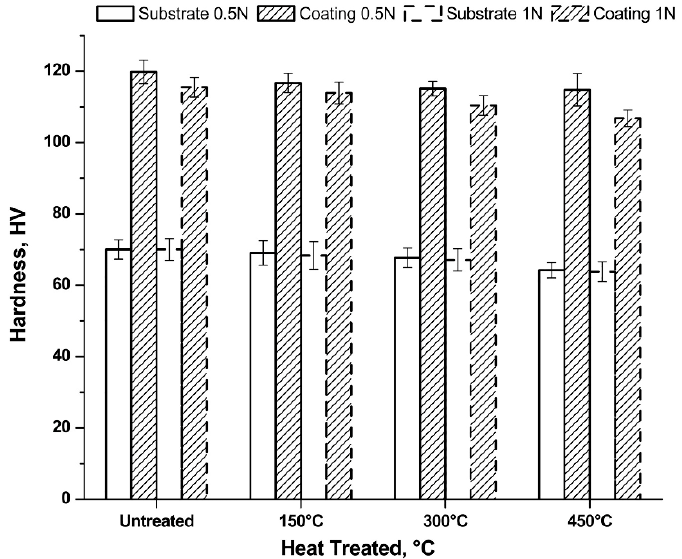
Figure 8. Hardness test results as function of load and heating